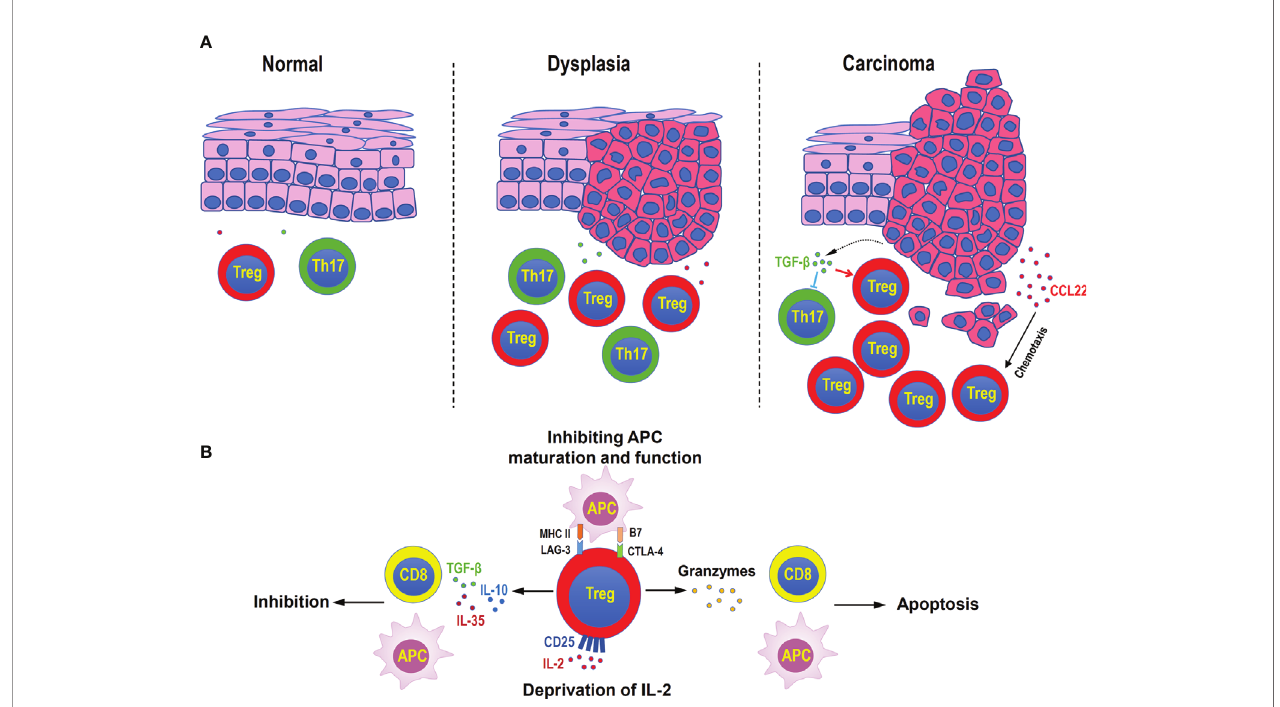
FIGURE 2 | Distribution and functions of Treg cells in head and neck squamous cell carcinoma. (A) Treg cells increase during the disease progression in oral mucosal dysplasia and squamous cell carcinoma. Malignant cells can secret CCL22 to attract Treg cells, or secret TGF- b to suppress in fl ammatory Th17 cells. (B) Immune suppressive mechanisms of Treg cells in head and neck squamous cell carcinoma. Treg cells can secret inhibitory cytokines, such as TGF- b , IL-10, and IL-35, to suppress the functions of antigen-presenting cells (APC) and CD8 + effector T cells, directly kill effector or APC by granzymes, consume of IL-2 by highly expressing CD25, and negatively regulate the maturation and functions of APC by immune checkpoint molecules, such as LAG-3 and